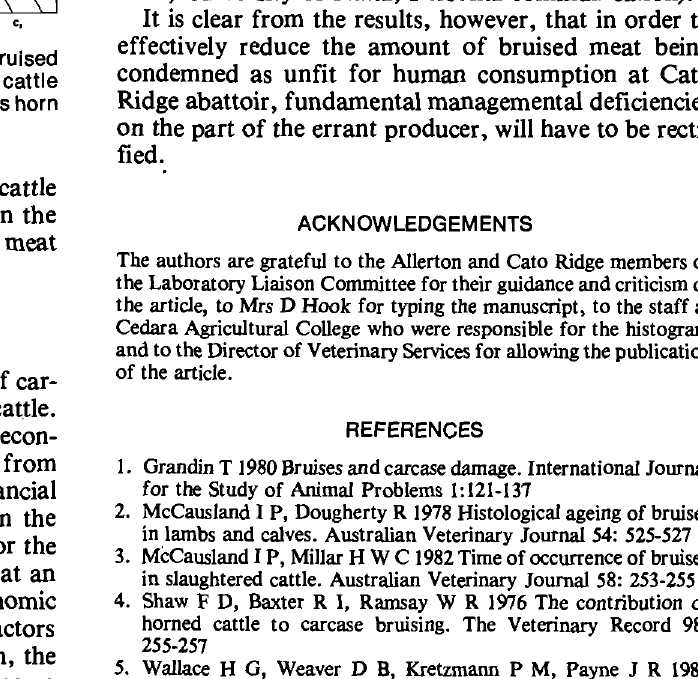
Fig. 1: Histogram showing the average amount of bruised meat condemned per animal from pens of cattle categorised according to the mixing of the various horn types.